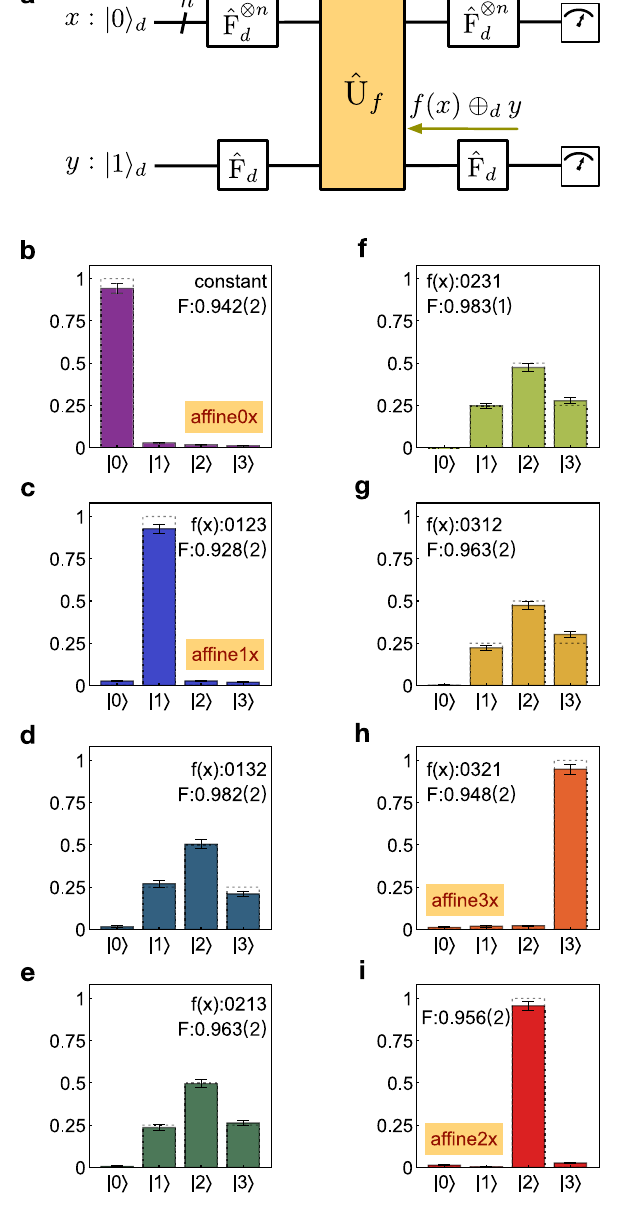
Fig. 4 Implementations of generalised Deutsch-Jozsa and Bernstein- Vazirani algorithms in quaternary. a Quantum logical circuit for implementing the d -ary Deutsch-Jozsa and Bernstein-Vazirani